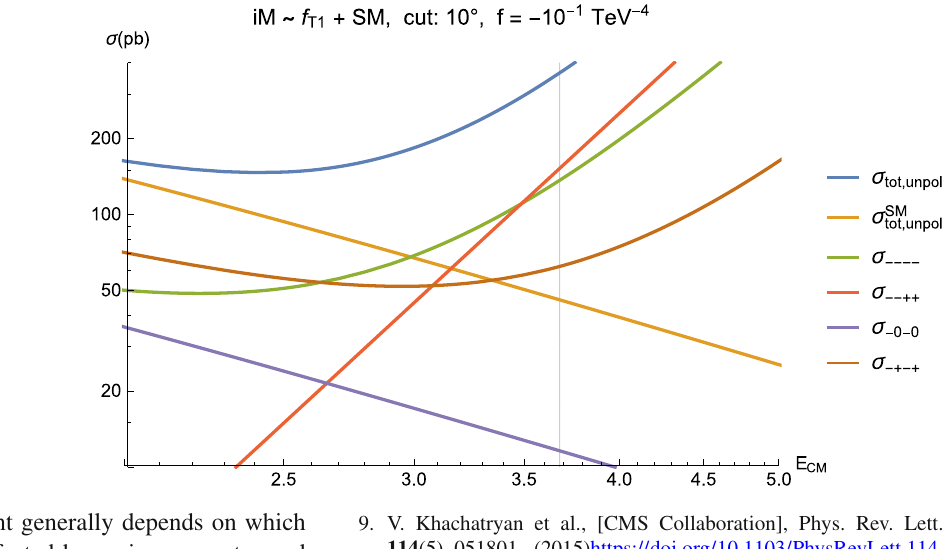
interference term at this point generally depends on which helicity combinations get affected by a given operator and how much they contribute to the total cross section in the SM. Interference is visible for O S 0 , O S 1 , O T 0 , O T 1 , O T 2 ,